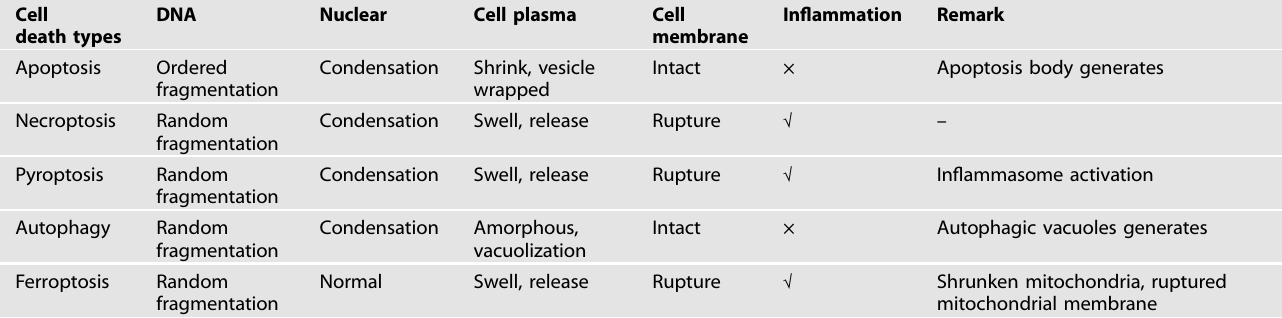
Table 1. Difference between regulated cell death